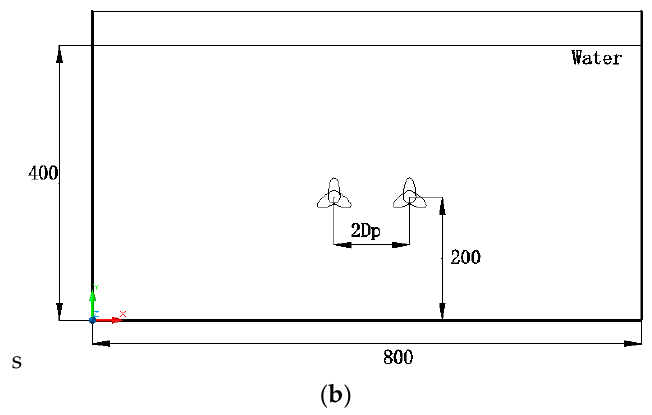
Figure 3. Experiment setup: ( a ) Front view; ( b ) Axial view.